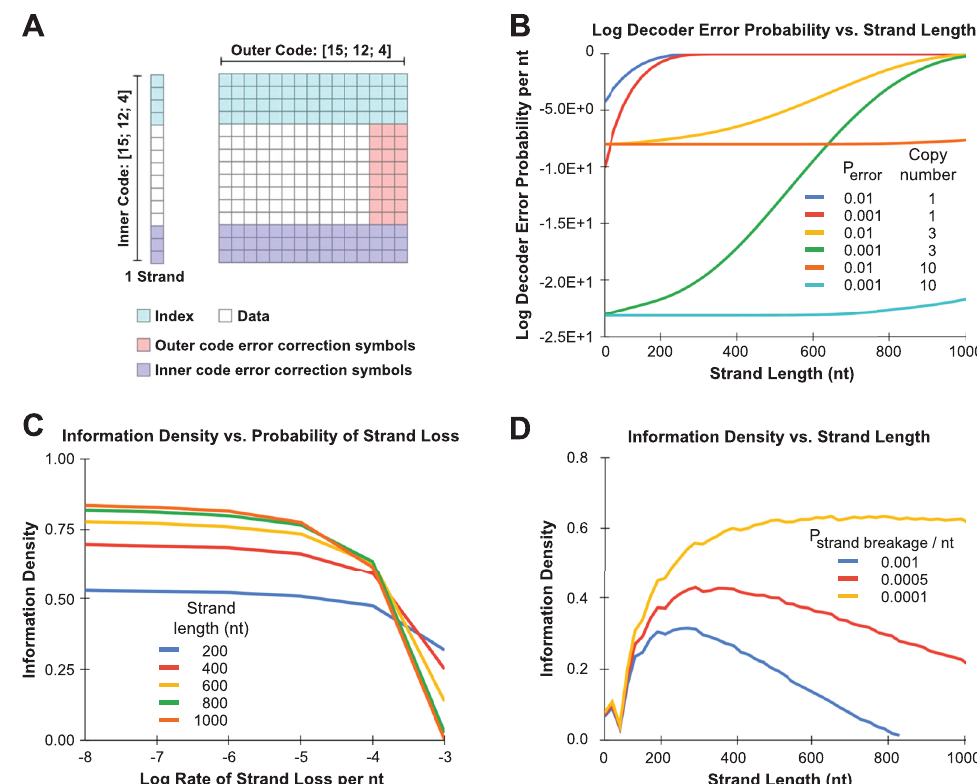
Fig. 2 Analysis of tradeoffs between system reliability, information density, strand length, and error rates. A Reed-Solomon inner-outer encoding scheme. B Relationship between log decoder error probability during RS decoding and DNA strand length, including the effects of symbol error rate (mutations, insertions, and deletion, P error ) and copy number. C Relationship between information density of a DNA storage system and the probability of symbol erasure (strand loss due to breakage) as a function of strand length. D Relationship between information density and strand length as a function of the probability of strand breakage. C and D assume a copy number of